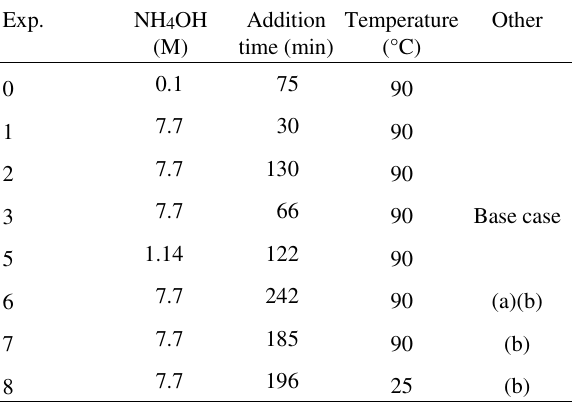
Table 1. Experimental conditions. (a) NH 4 OH soln. was technical grade, pH = 10; (b) Open reactor; slightly different concentrations of reactants.